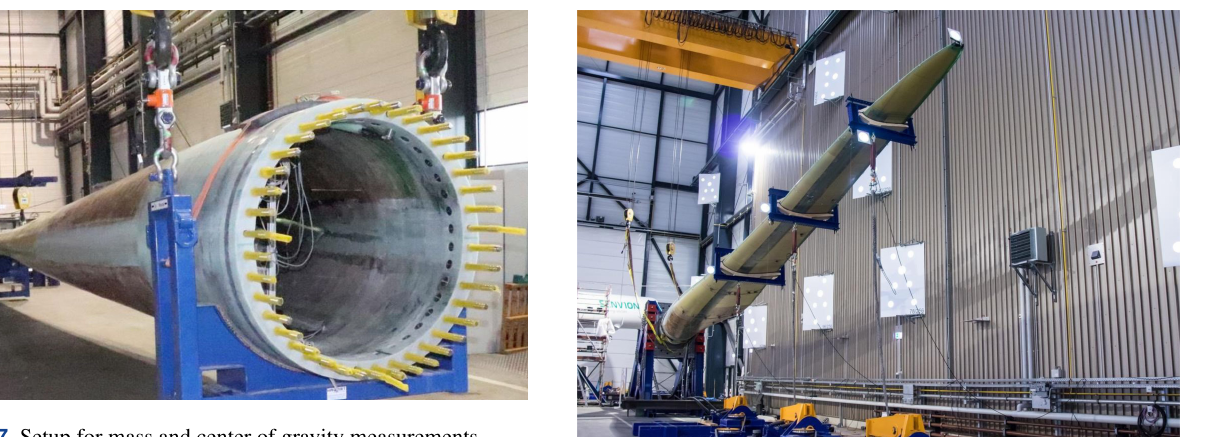
Figure 8. Photo of a static blade test configuration in flapwise di-